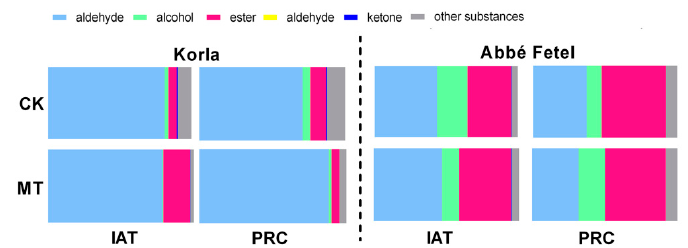
Figure 2. Effect of melatonin on the relative content of volatile compounds classes in postharvest fruit.